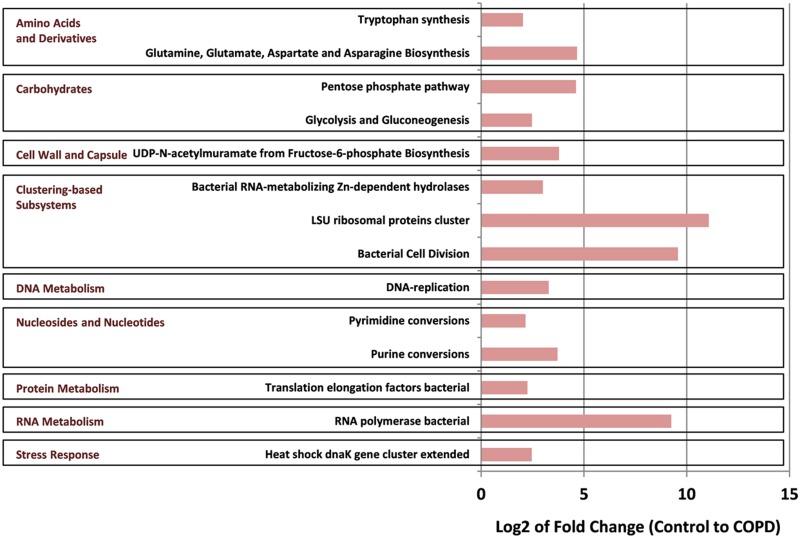
Significant differences in functional classification abundance from Control to COPD.Using MetaboAnalyst 2.0, t-Tests and fold-changes were calculated from normalised percentages of reads, with only those with a P value of < 0.05 charted. Functional classifications are grouped by their Level 1 classification. Only those differences at the Level 3 function are charted, with Levels 1 and 2 shown in S2 and S3 Figs respectively. Differences at Level 3 appear to centre on differences to those reads aligned to functional roles in bacterial cell division.